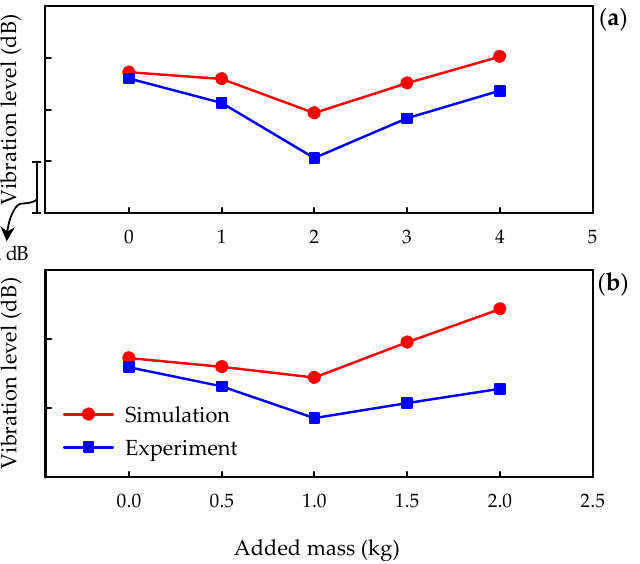
Figure 18. Comparison of vibration levels between the simulation and experiment obtained by changing the amount of added mass: ( a ) the radiator and ( b ) the intercooler.